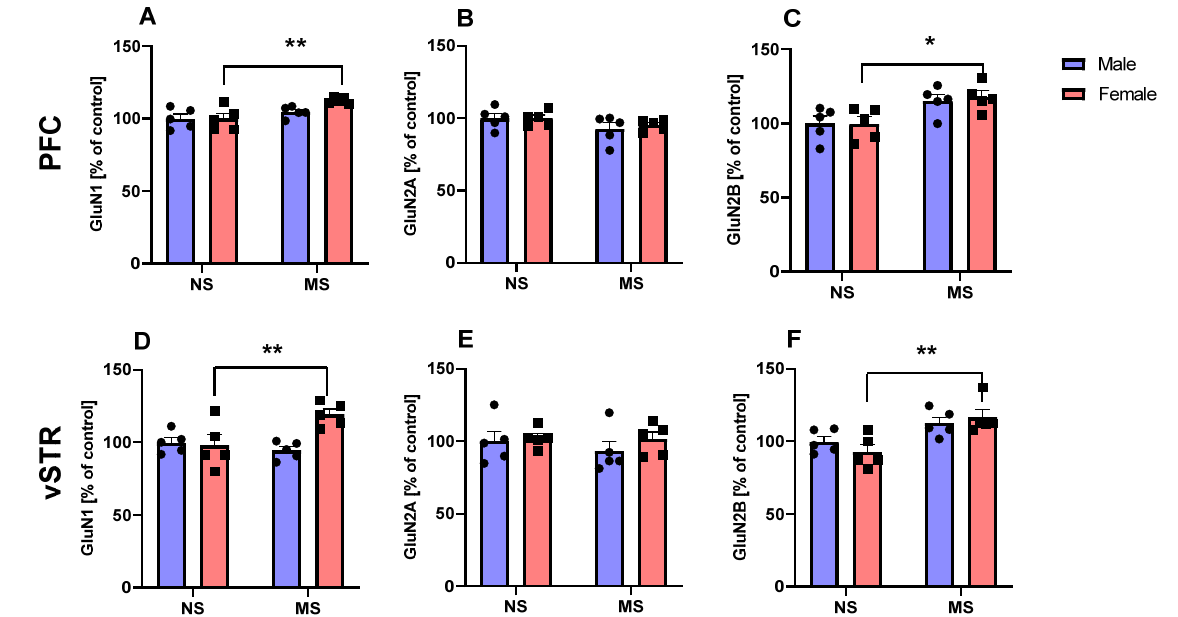
Figure 3. Effect of MS on GluN1 ( A , D ), GluN2A ( B , E ), and GluN2B ( C , F ) subunits of NMDAR in the PFC and vSTR of adolescent male and female rats (PND22) subjected (N = 5/group) to MS for 180 min during PND1-21. The concentration of proteins was calculated from a standard curve and presented as a percentage of control. PND—postnatal day; MS—maternal separation; NS—non-separated; PFC—prefrontal cortex; vSTR—ventral striatum. * p < 0.05; ** p < 0.01 vs non-separated.